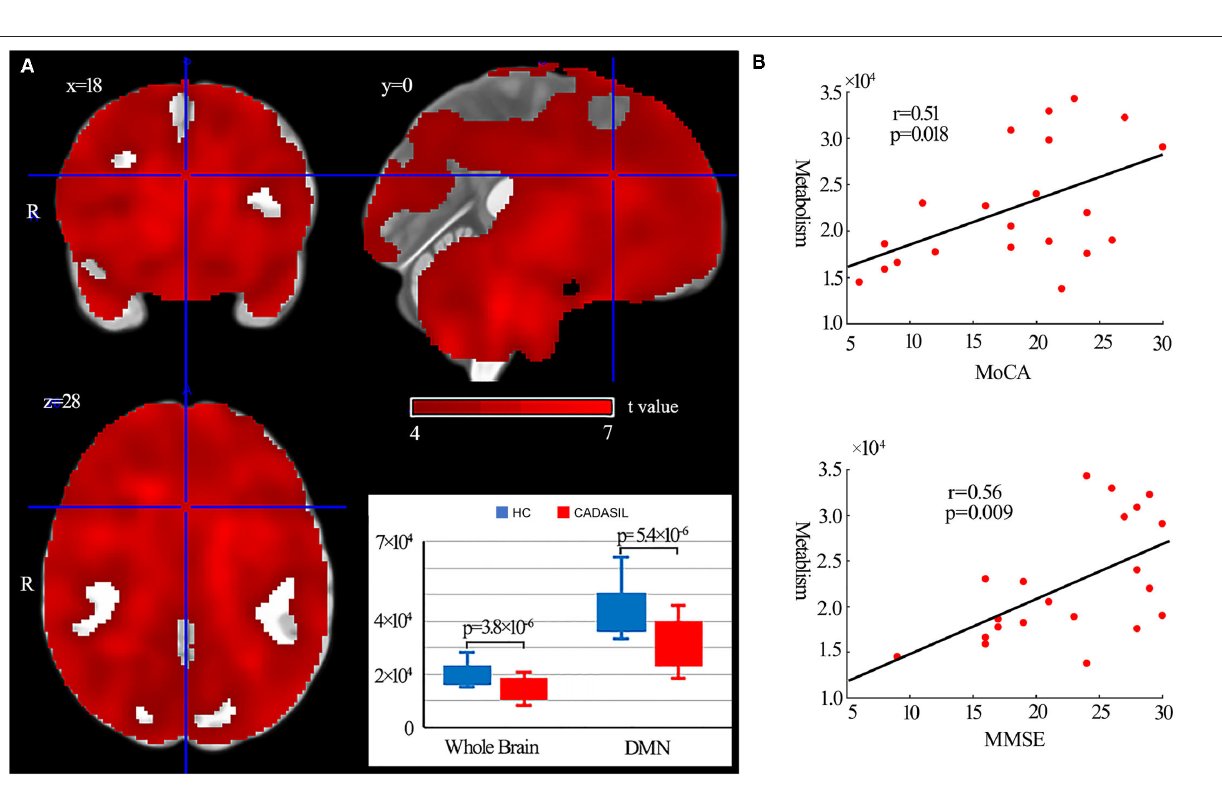
Frontiers in Neurology |